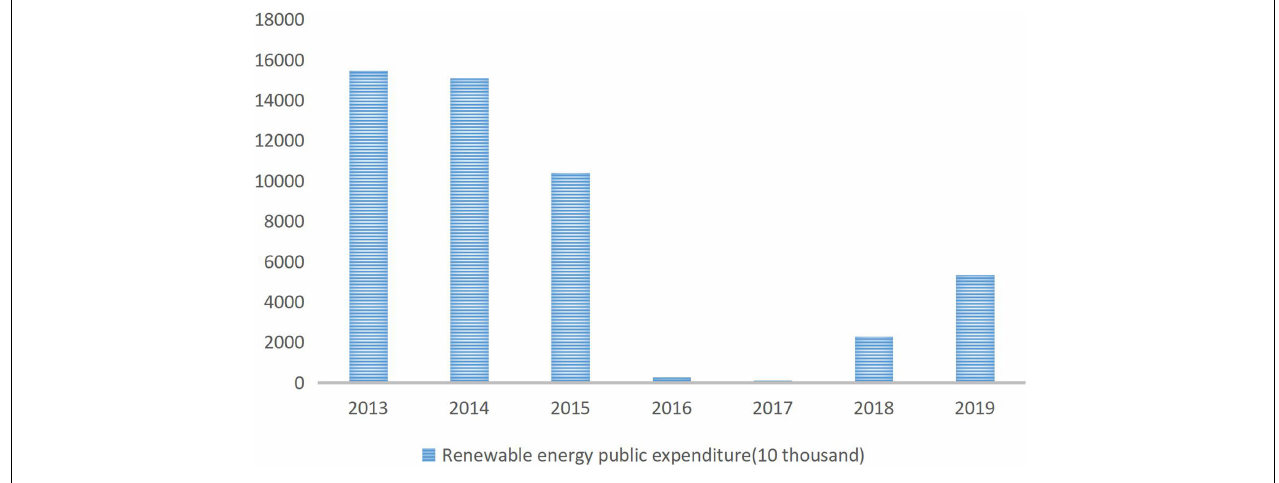
FIGURE 1 | Public budget expenditure for renewable energy industry (unit: 10,000